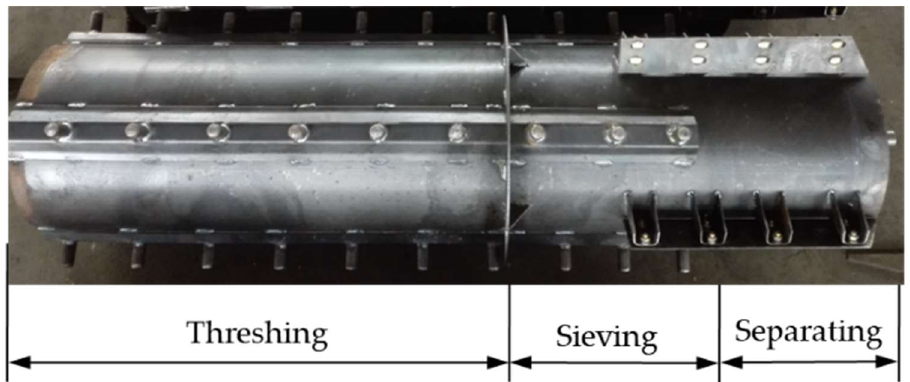
Figure 4. The fullcolumn tooth threshing drum (TD2 for short).